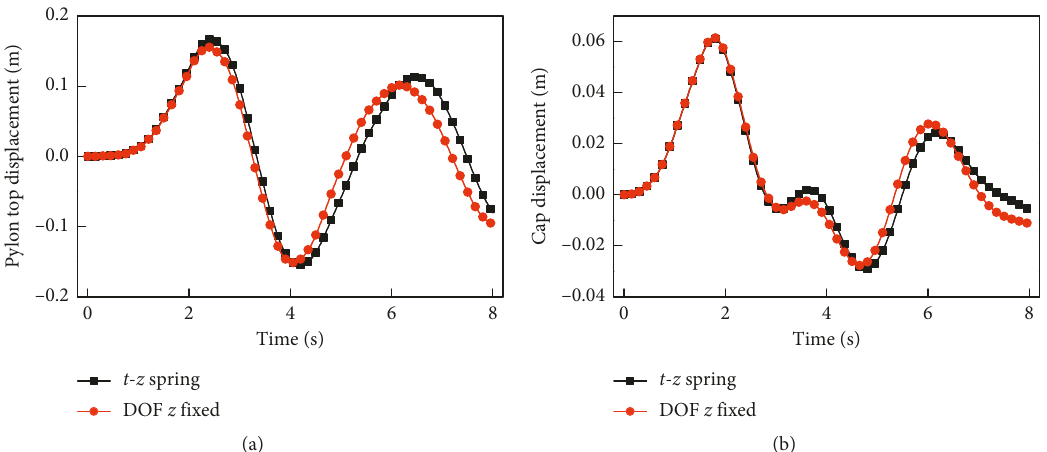
Figure 13: Bridge pylon lateral displacements for different axial SPI considerations. (a) Cap lateral displacement. (b) Pylon top lateral displacement.